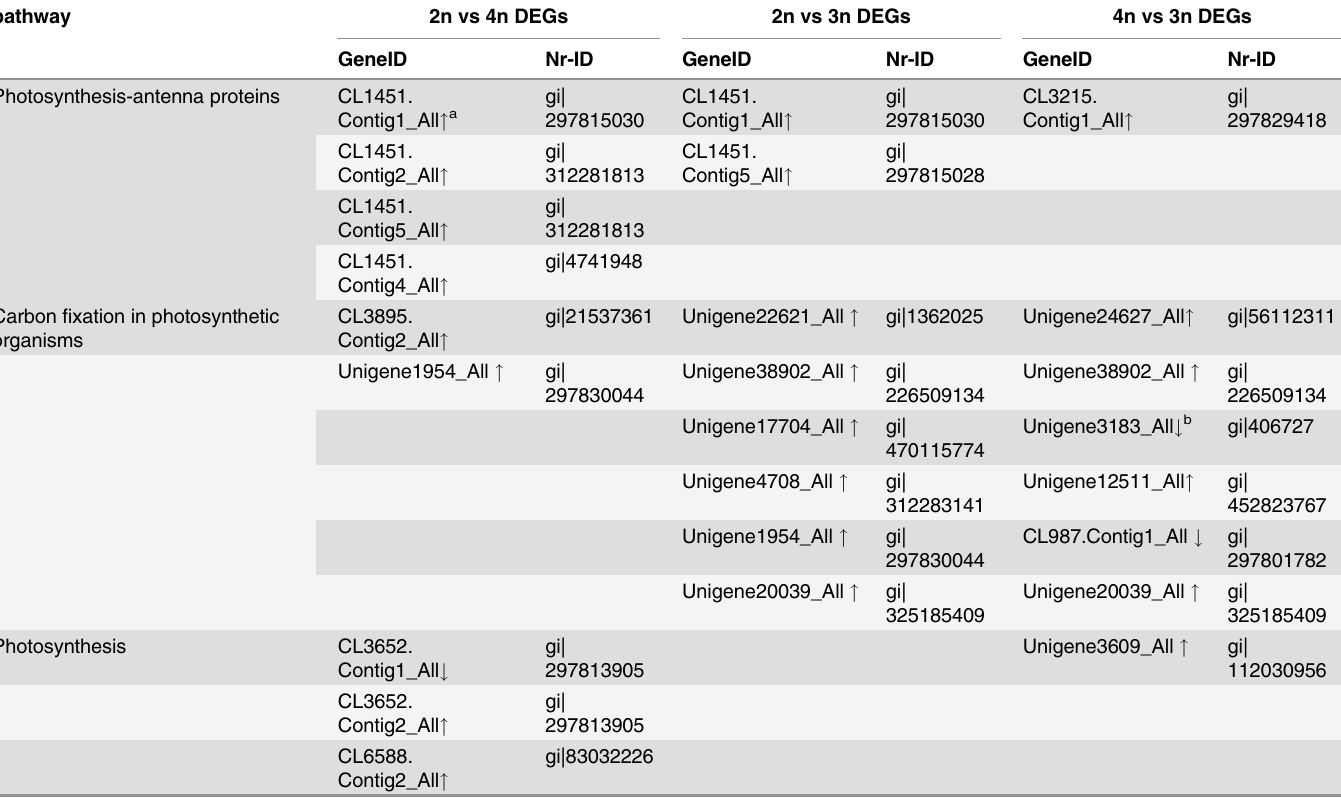
Table 3. Functional classi fi cation of some differentially expressed genes (DEGs) related in photosynthesis via KEGG pathway enrichment analysis. pathway